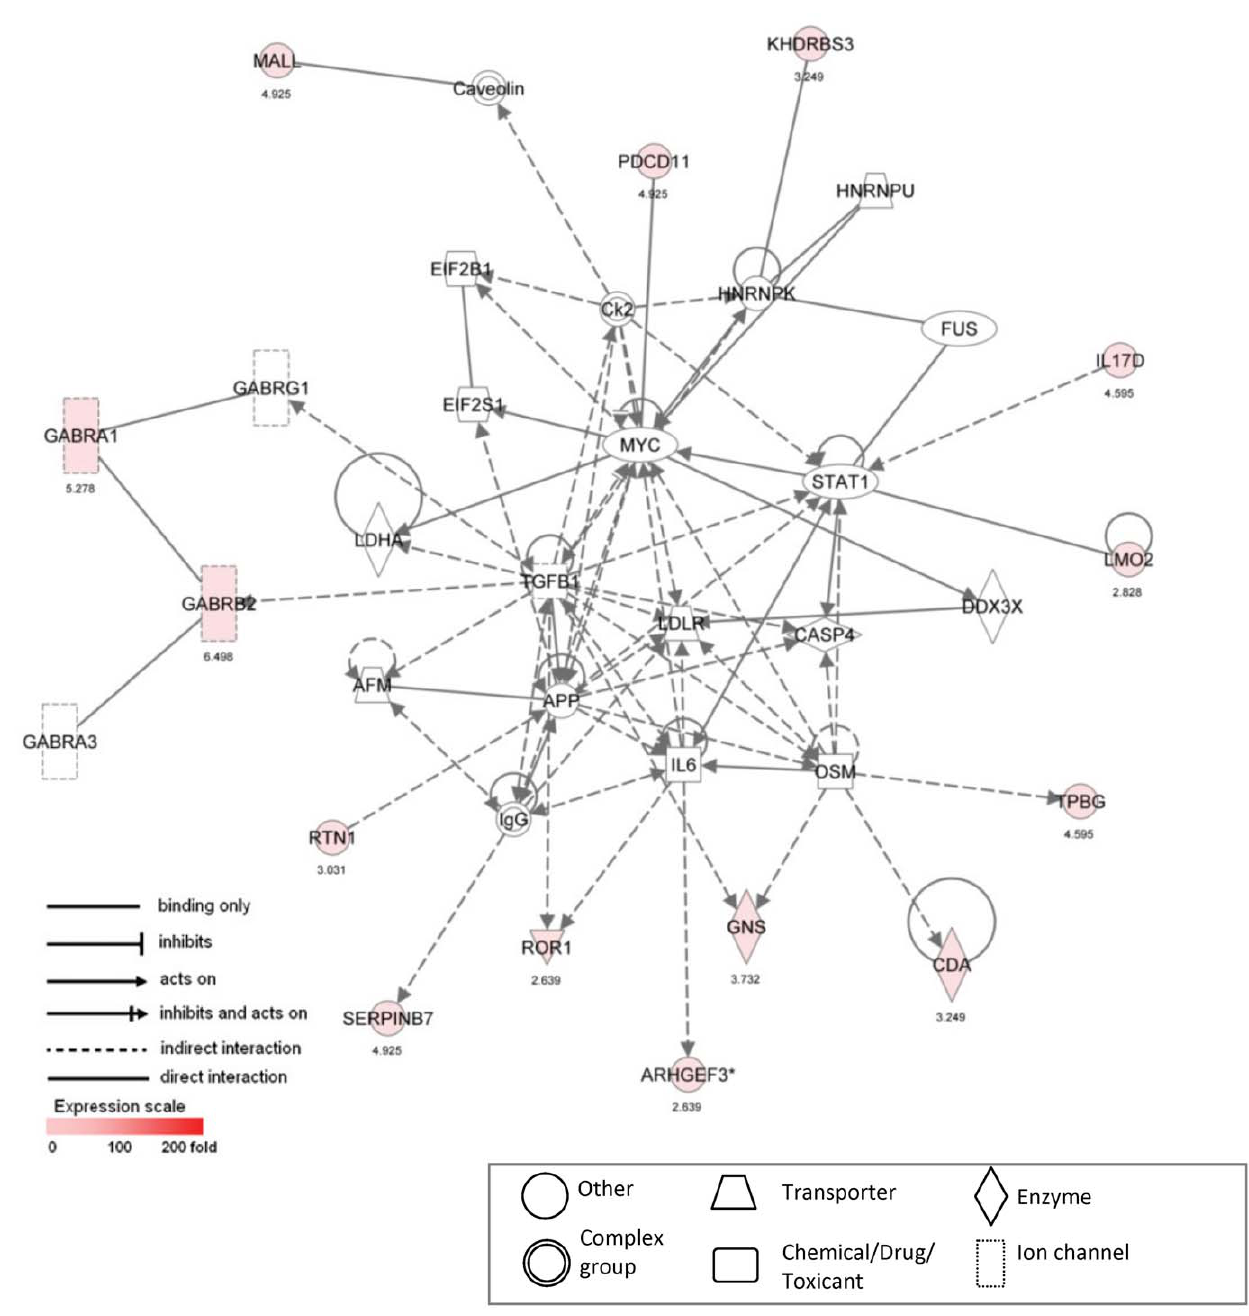
Figure 5. Ingenuity pathway analysis Network # 3. Ingenuity pathway analysis was used to assemble a network based upon 14 differentially expressed focus genes that were upregulated in male VICs compared to female VICs. Corresponding fold change values are listed beneath each gene label. Focus gene names are defined in Table S1.